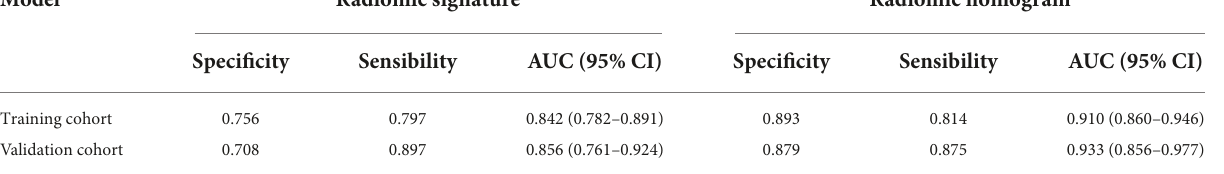
TABLE 2 Predictive performance of the radiomic signature and radiomic nomogram.